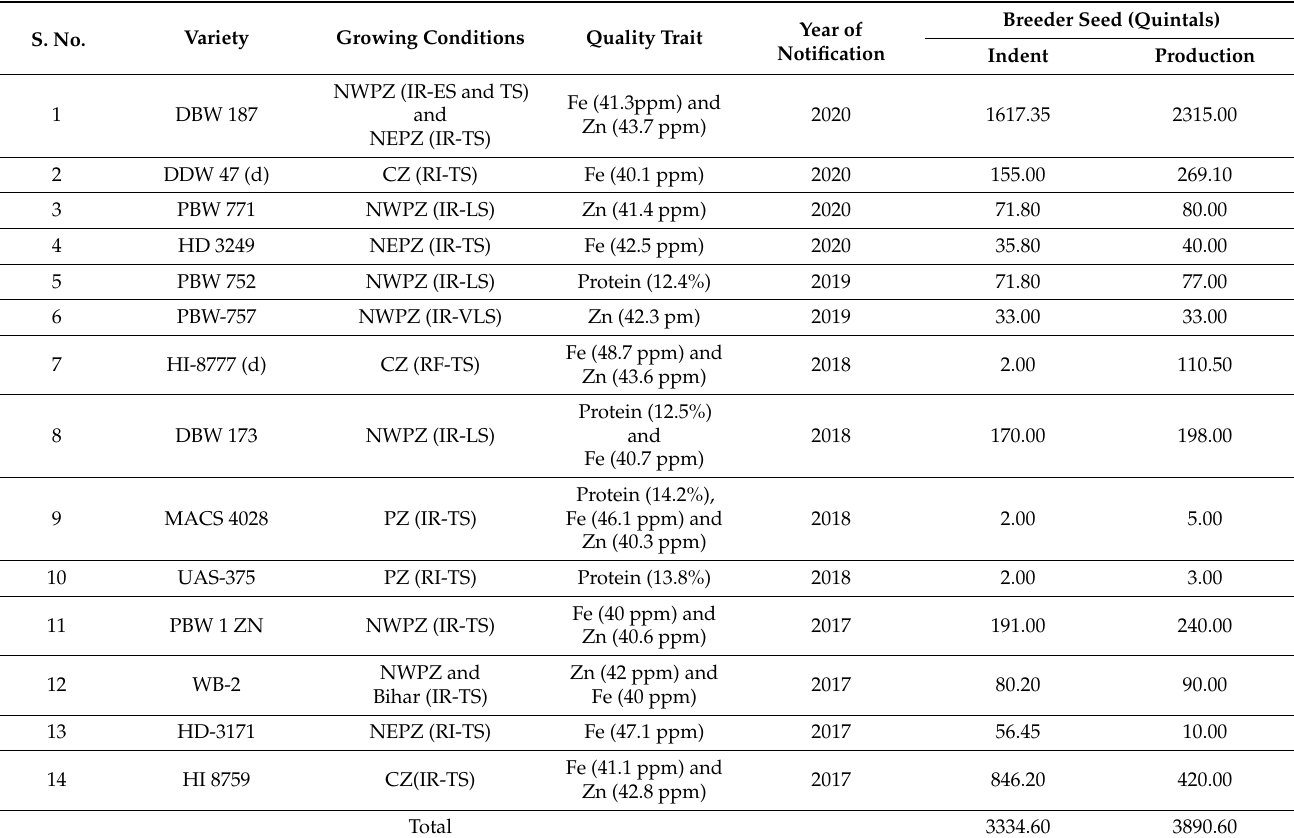
(NWPZ: North Western Plains Zone, NEPZ: North Eastern Plains Zone, CZ: Central Zone, PZ: Peninsular Zone, IR: Irrigated, RI: Restricted Irrigation, RF: Rainfed, ES: Early Sown, TS: Timely Sown, LS: Late Sown, VLS: Very Late